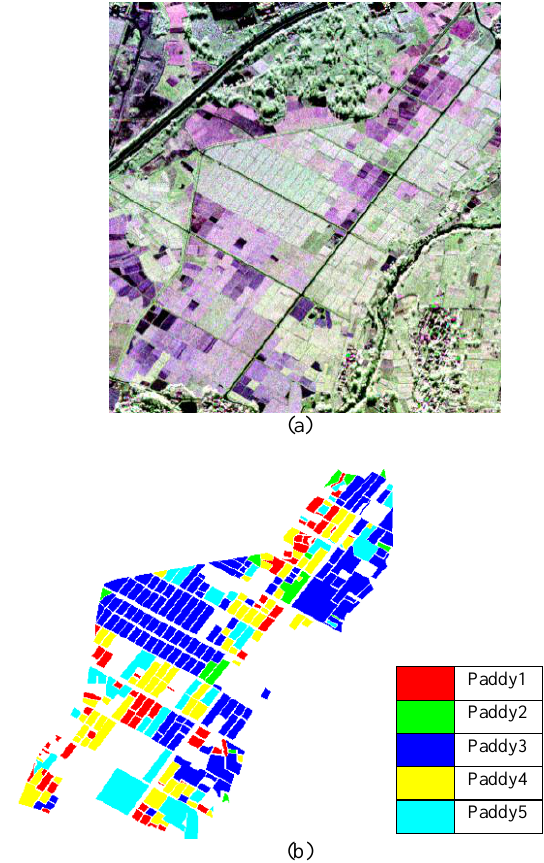
Figure 2. PolSAR image of Paddyland in Linshui City, (a) Pauli based on PolSAR image: red for |HH-VV|, green for 2|HV|, and blue for |HH+VV|. (b) Ground truth region of total five classes.